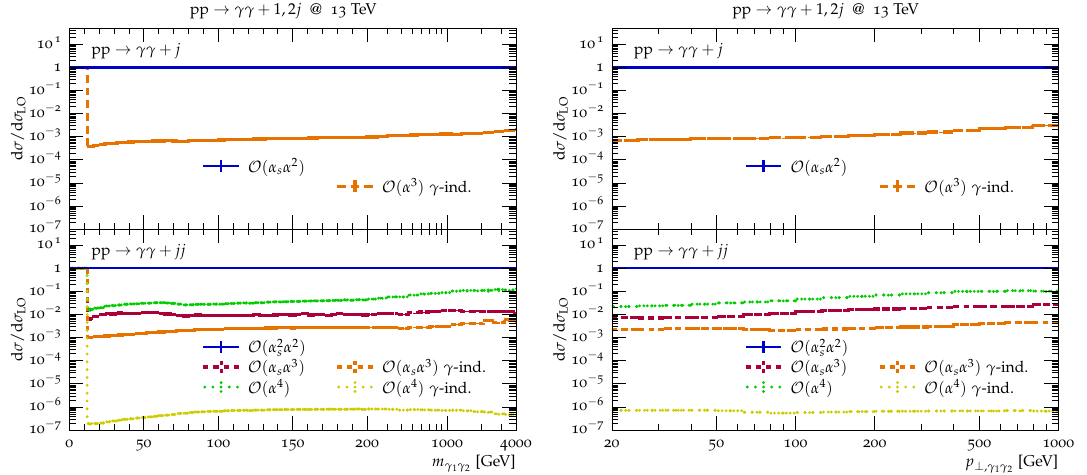
Figure 11 . Tree-level contributions from subleading orders and photon initiated processes for the invariant mass and the transverse momentum of the leading and subleading isolated photon system in (cid:13)(cid:13) + 1 ; 2 jets production at 13 TeV at the LHC. Note that on the left plot the x -axis is given as a logarithmic scale for values above 200